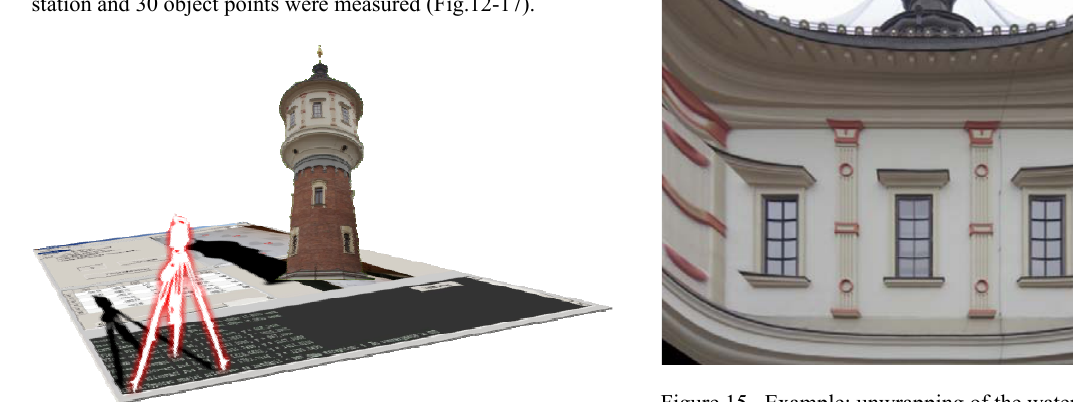
Figure 15. Example: unwrapping of the water tower upper part